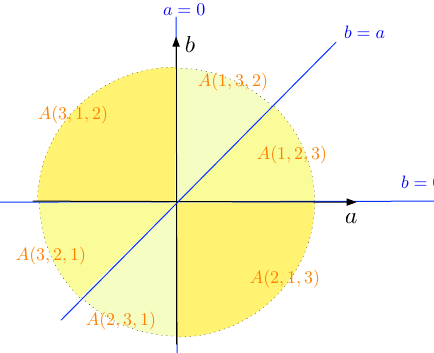
Figure 2. The ( a , b ) -plane is partitioned (apart from shared borders) in six unbounded pie-shaped slices (the sets A ( i 1 , i 2 , i 3 ) in different shades of yellow), which are determined by the lines a = 0, b = 0 and b = a (in